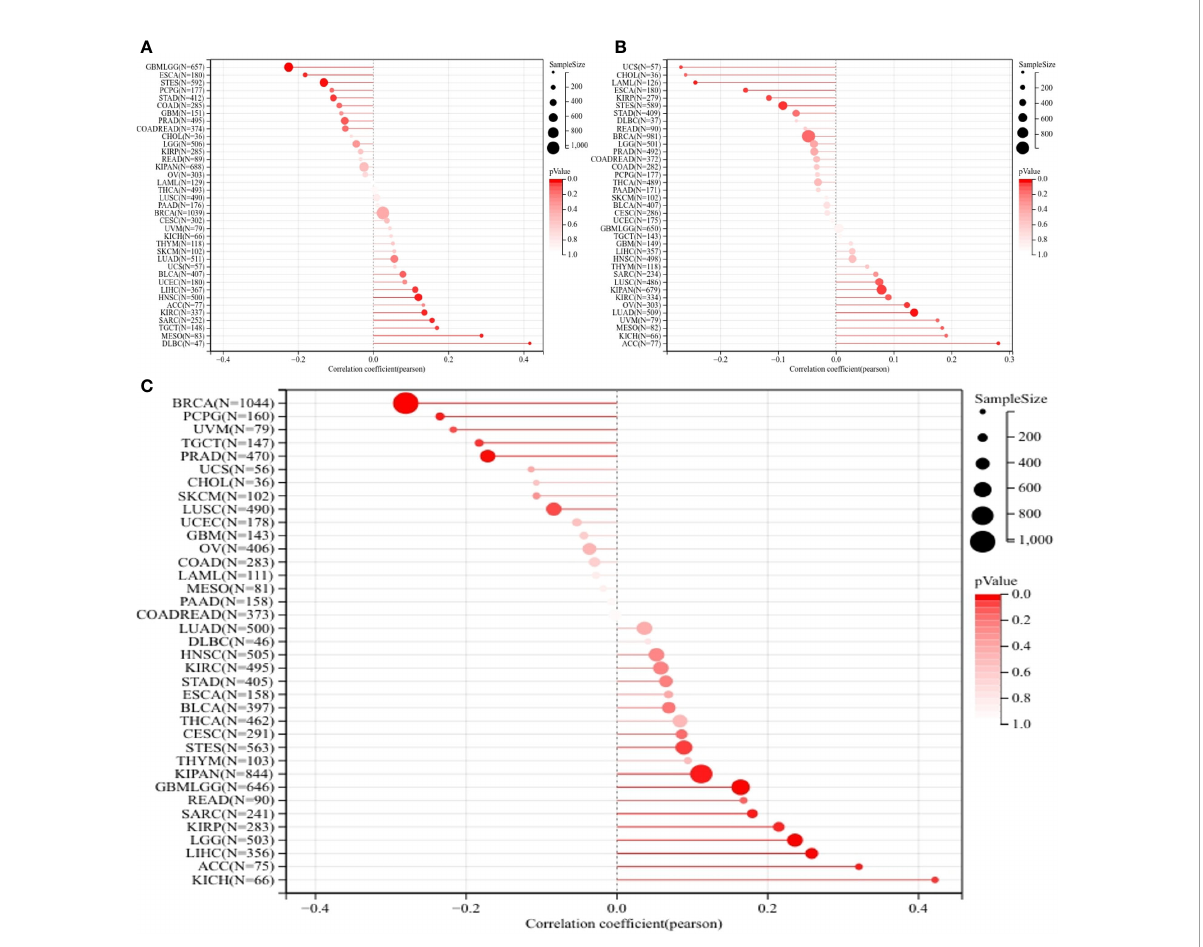
FIGURE 4 Homologous recombination de fi ciency (HRD), Microsatellite instability (MSI), and Tumor mutation burden (TMB) analysis in pan-cancers. (A) Correlation between ERCC1 and TMB in pan-cancers. (B) Correlation between ERCC1 and MSI in pan-cancers. (C) Correlation between ERCC1 and HRD in